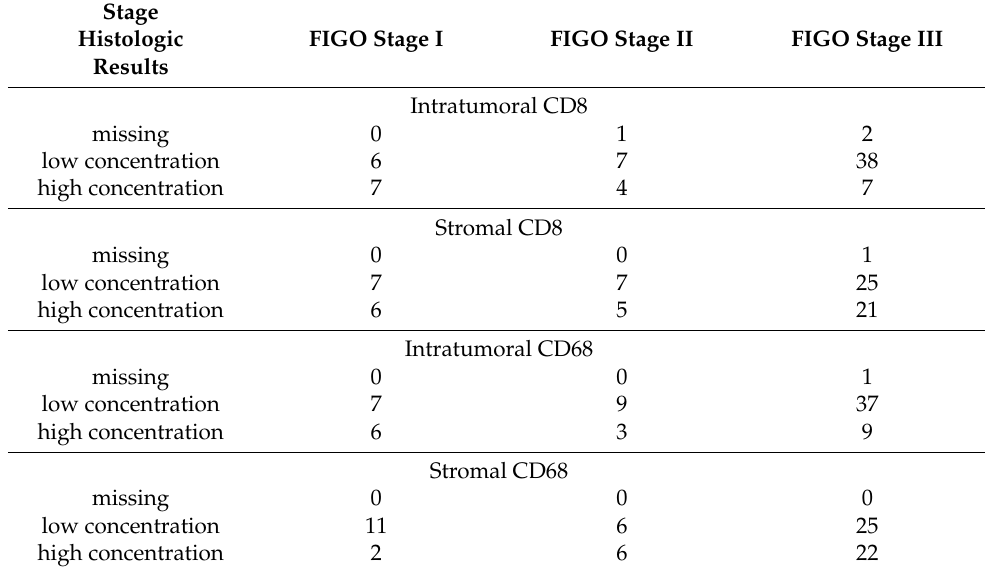
Table 4. Distribution of patients according to FIGO stage and immunohistochemical